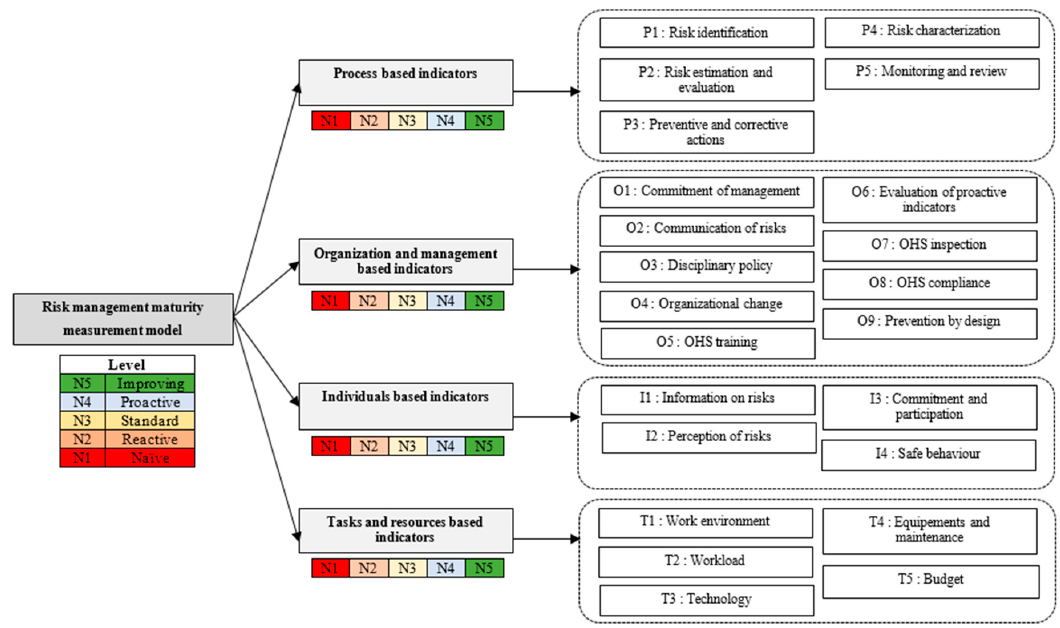
Figure 6. Preliminary model of OHS management maturity measurement.